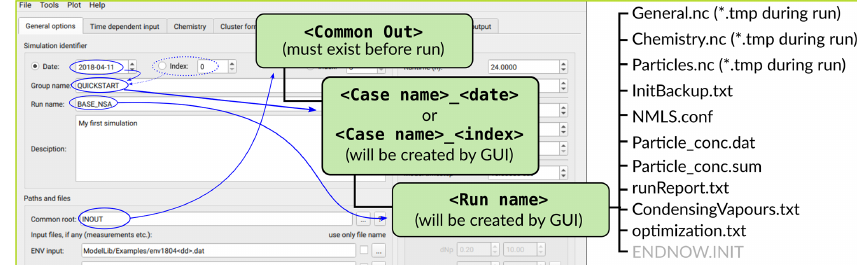
Figure B1. Output directory naming and the files created in each